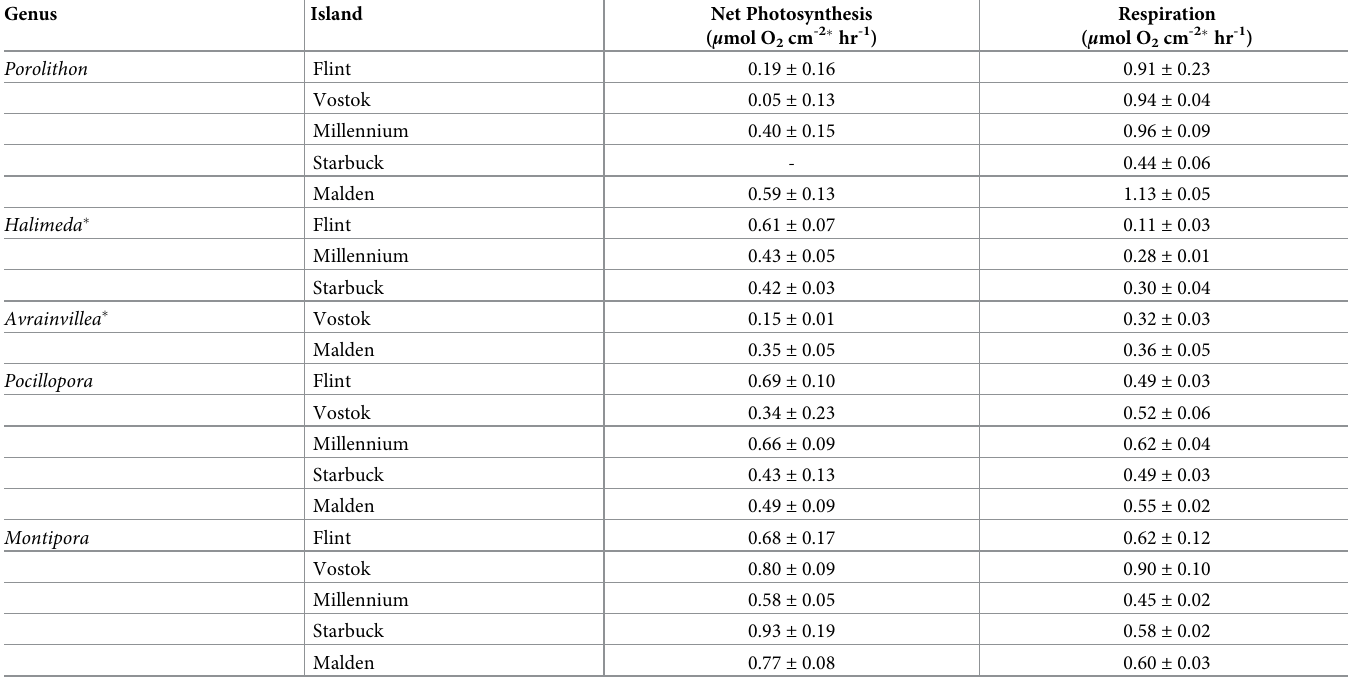
Table 2. Photosynthesis and respiration rates.